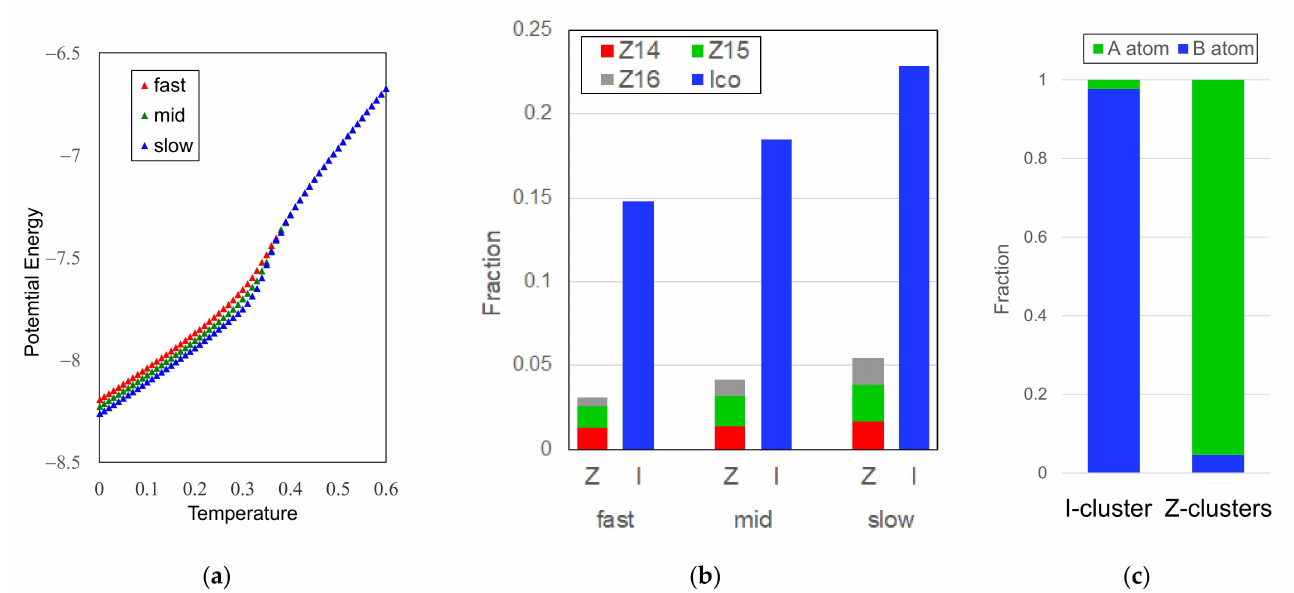
Figure 4. ( a ) Temperature dependence of potential energy in cooling processes of the r BB = 0.8 A 50 B 50 system with different cooling rates. ( b ) Cooling rate dependence of the fraction of I- and Z-clusters in quenched glassy A 50 B 50 phases. ( c ) Fraction of atom species of the central atoms of I- and Z-clusters in the glassy A 50 B 50 phase formed by slow-cooling.